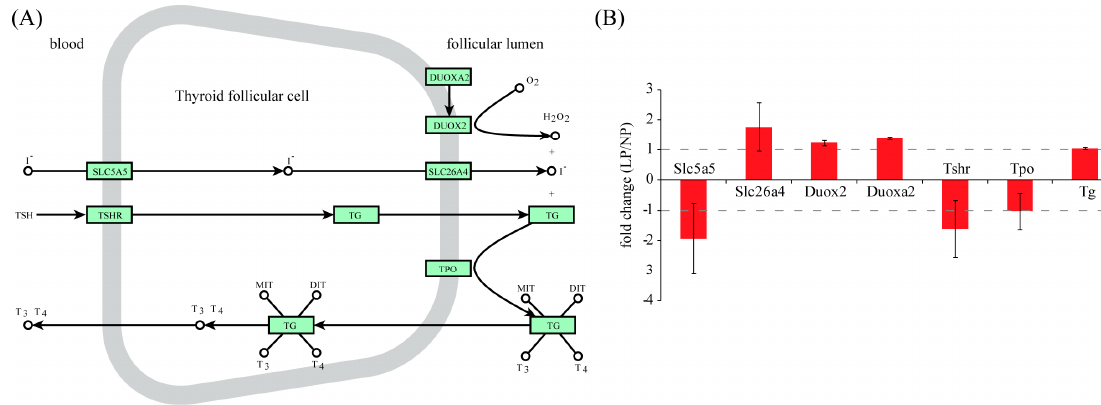
Figure 3. Gene expression analysis of thyroid hormone synthesis pathway. ( A ) Visualization of the thyroid hormone synthesis pathway. Rectangular nodes represent genes and circular nodes denote small molecules. Edges represent reactions derived from KEGG pathway rno04918. This graph is generated using the Cytoscape software. TSH, thyroid stimulating hormone; TSHR, thyroid stimulating hormone receptor. SLC5A5, solute carrier family 5 member 5; SLC26A4, solute carrier family 26 member 4; TG, thyroglobulin; TPO, thyroperoxidase; DUOXA2, dual oxidases A2; DUOX2, dual oxidases 2; ( B ) Bar plot showing fold change values based on RNA-seq data. None of these genes were differentially expressed according to the criteria of fold change > 2 and adjusted p -value < 0.01.